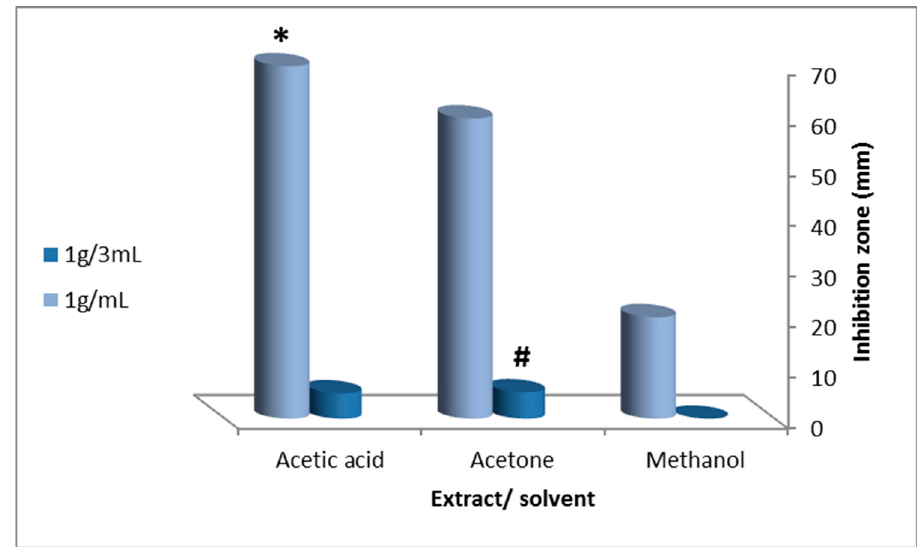
Figure 2. Antifungal activity of viscera (two concentrations) extracted by (methanol, acetone and acetic acid) of the garden snail, H. aspersa , against Candida albicans . The values are expressed asmean ± SD; indicates a significant difference between tissue extract and concentration; indicates a significant difference between extracting solvents (ANOVA, p ≤ 0.05). indicates a The antifungal drug fluconazole (25 µg/mL) inhibited A. brasiliensis and A. flavus growth at 17 ± 0.4 mm and 14 ± 0.1 mm, respectively. The solvents had no effects on fungal growth except for acetic acid (inhibition zone = 15 ± 0.1 mm and 10 ± 0.5 mm for A. brasiliensis and A. flavus , respectively) (Figure 1). Both A. flavus and A . brasiliensis growth was inhibited by all extracts at 1 g/mL. Still, inhibition was significant for the acetic acid extract against A. brasiliensis (ANOVA, p = 0.02, 50.3 ± 3.5 mm) (Figures 1 and 3). The most significant growth inhibition was observed for A. flavus against acetic acid and acetone extracts (inhibition zones = 38 ± 1.7 mm and 3.1 ± 0.7 mm, respectively).